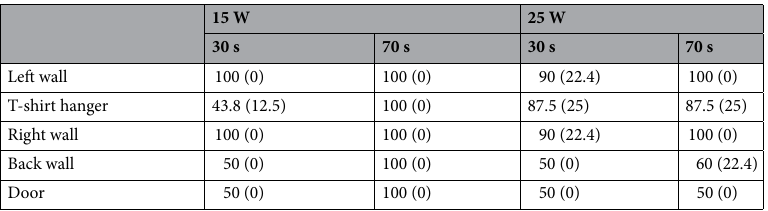
Table 1. Summary of light distribution within the UV-C disinfection cabinet for each lamp wattages. Note that the minimum possible fluence for each colorimetric range is used for qualitative fluence values. Values in brackets represent standard deviation. (15 W n = 5, 25 W n = 4).